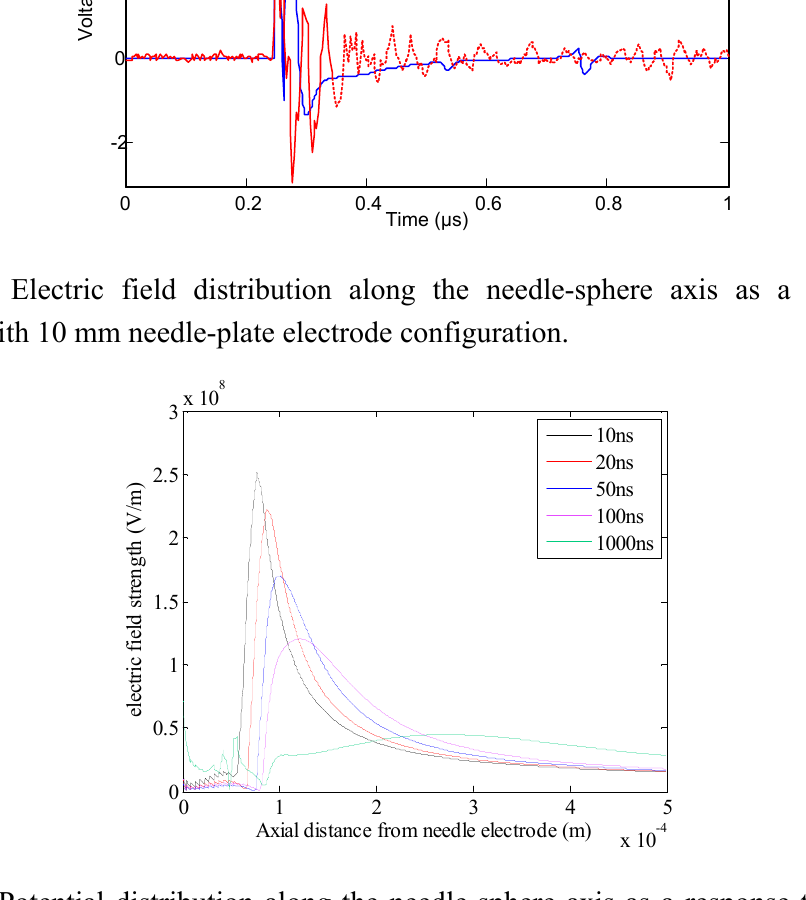
Figure 21. Potential distribution along the needle-sphere axis as a response to 1.2 PDIV with 10 mm needle-plate electrode